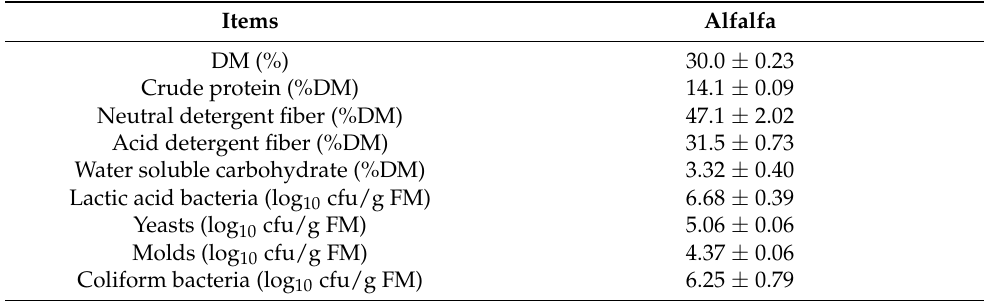
Table 1. Chemical composition and microbial population of fresh alfalfa prior to ensiling ( ± SD, n = 3).